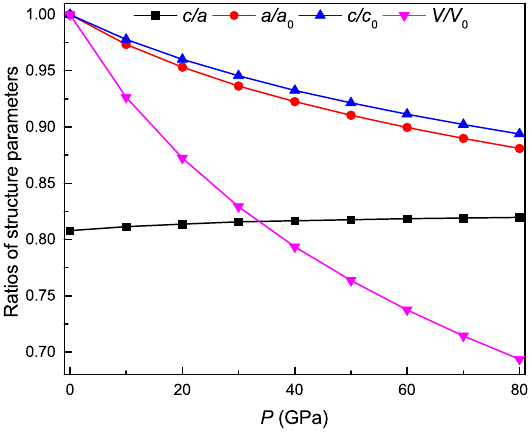
Figure 2. The ratios of structural parameters as a function of pressure for Ti 3